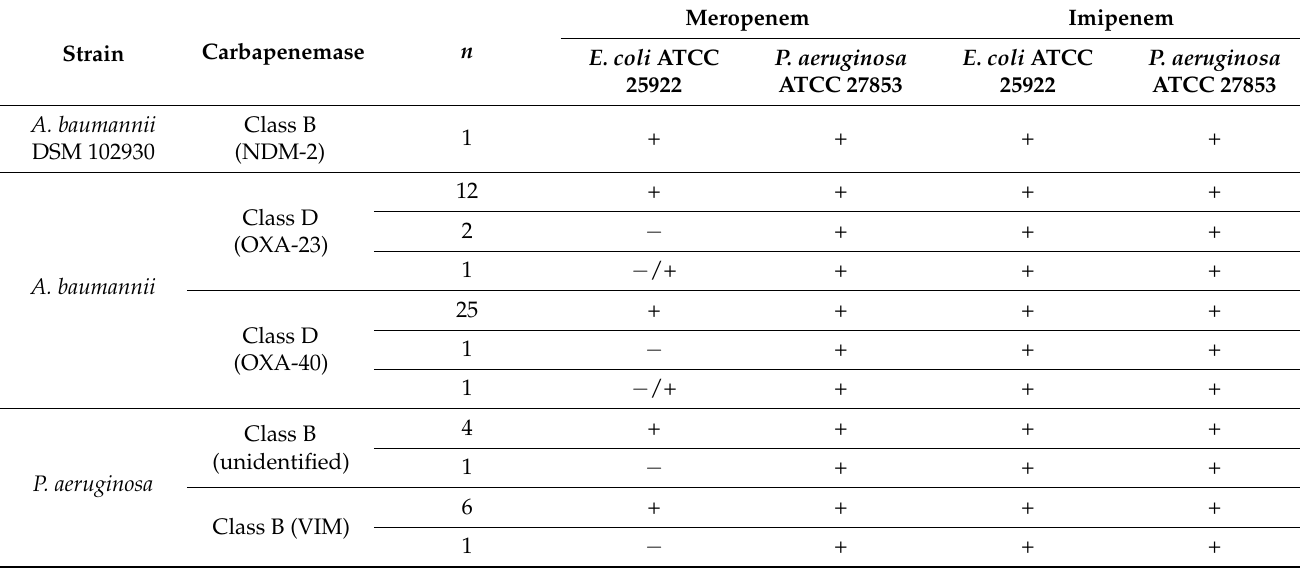
Table 1. CIM test results for the carbapenemases-positive strains ( n = 55).